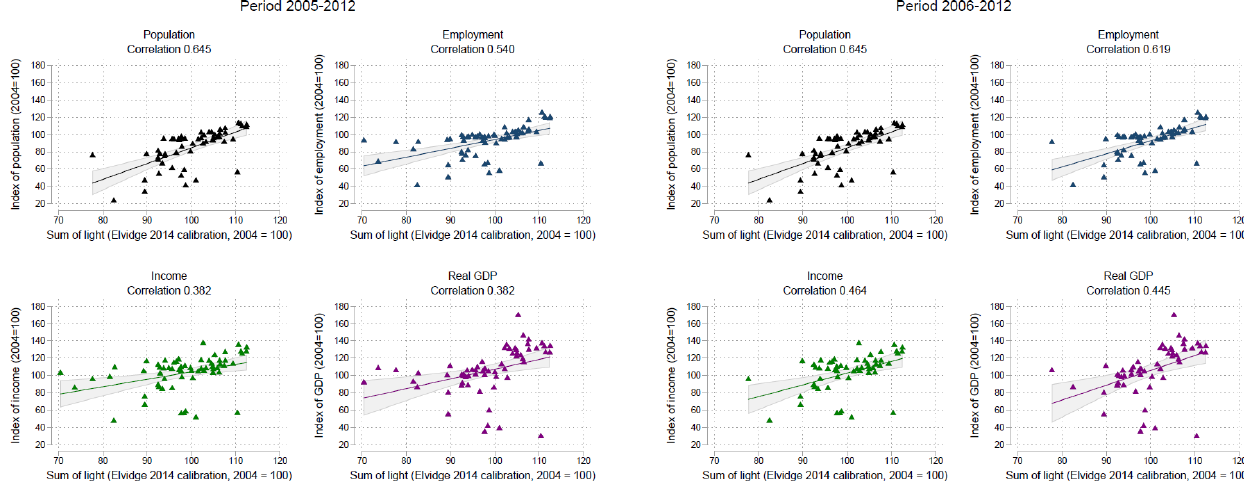
Figure A6. Indexed economic indicators and total sum of light for the eight affected counties after Katrina (starting in 2005 vs. 2006). Correlations of economic indicators and night lights (varying years). Night lights based on Elvidge et al. (2014) calibration, indexed to 2004 = 100. Right panel: population data are for 2006–2012 only.